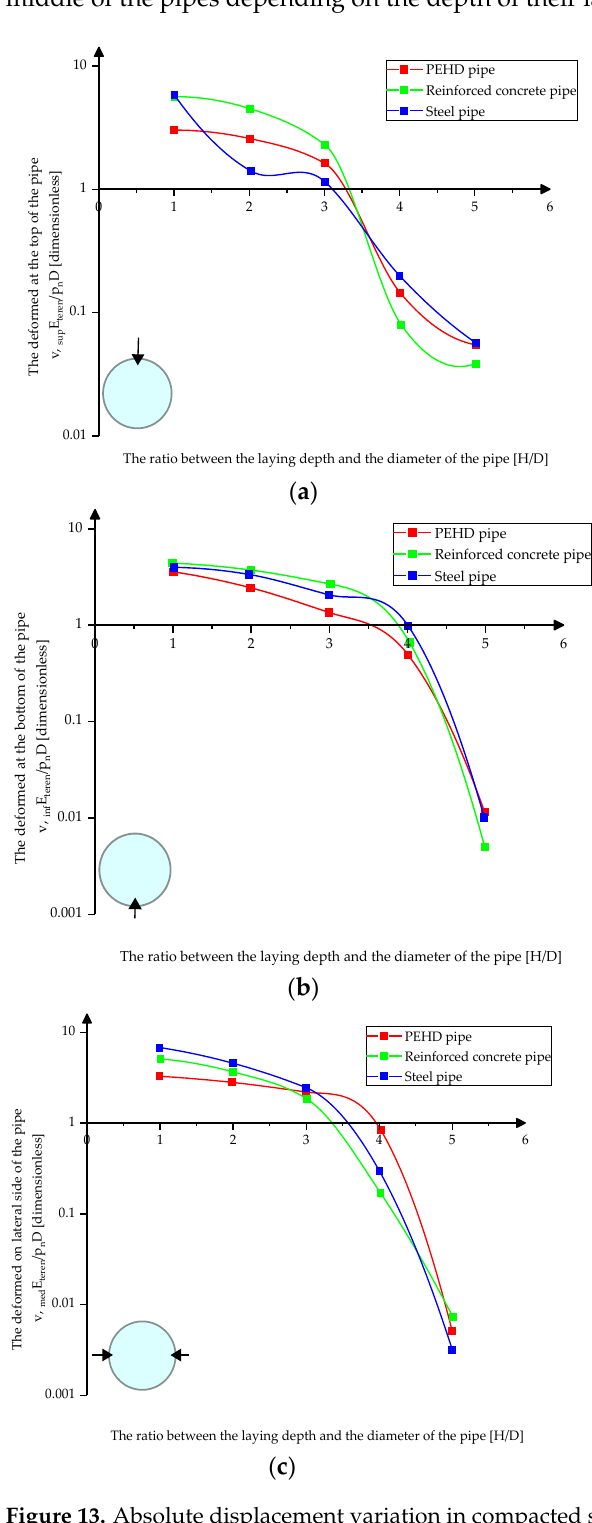
Figure 12. Absolute displacement variation in loose sand ( a ) at the top of the pipes ( b ) at the bottom of the pipes ( c ) in middle sections.